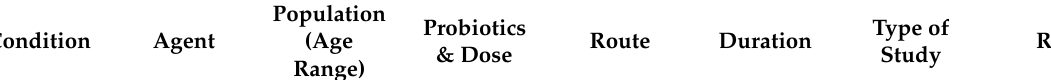
Table 3. Probiotics used in clinical trials in gastroenteritis